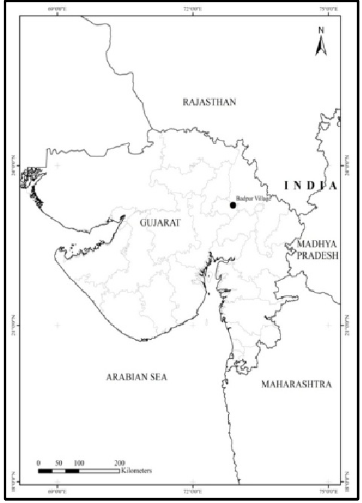
Figure 2. Location of study